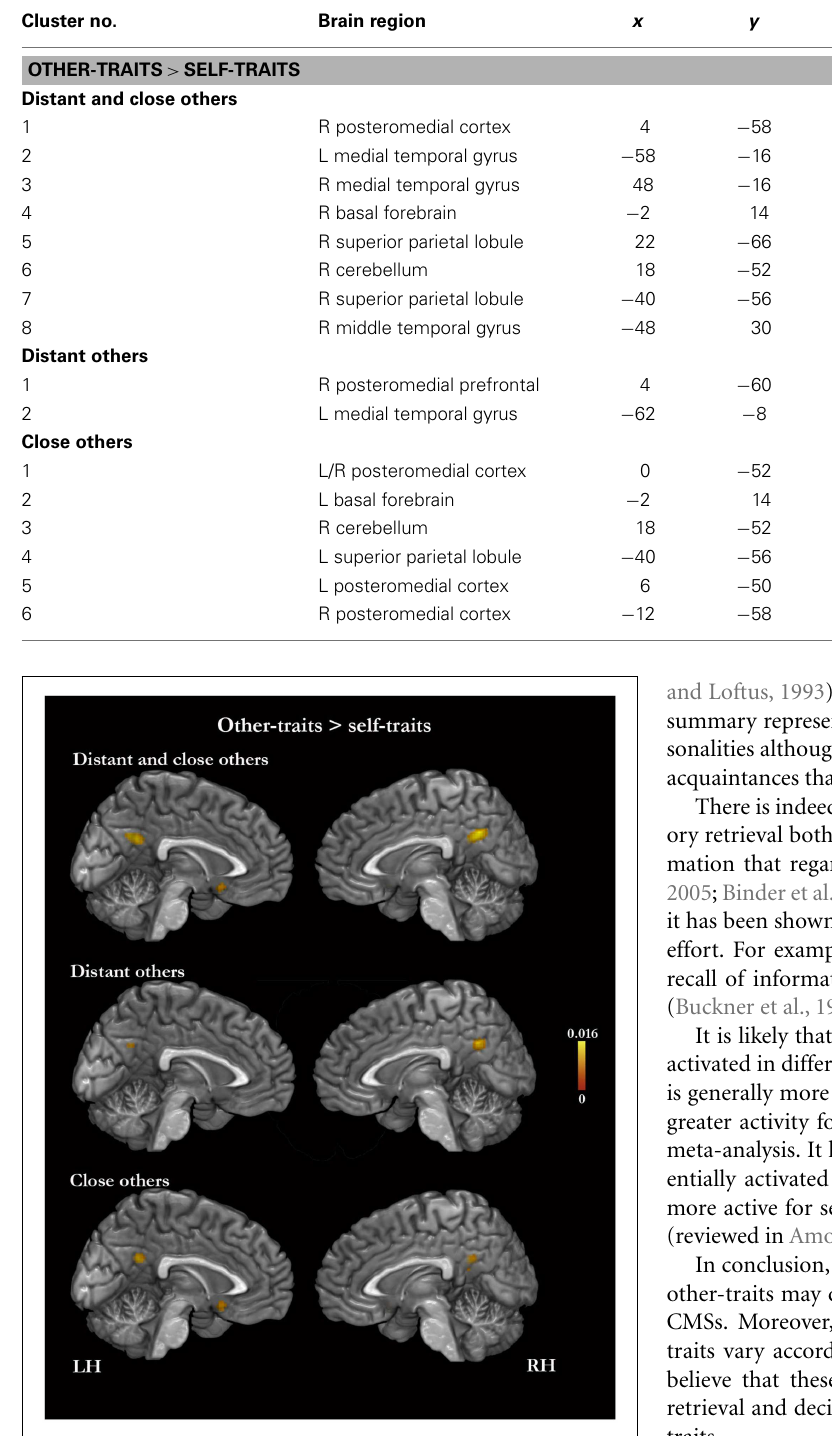
FIGURE 4 | Meta-analysis of activation foci for other-traits compared with self-traits in relation to both kinds of other combined (61 foci; 12 experiments), to distant kinds of other (23 foci; 7 experiments), and to close kinds of other (38 foci; 6 experiments)